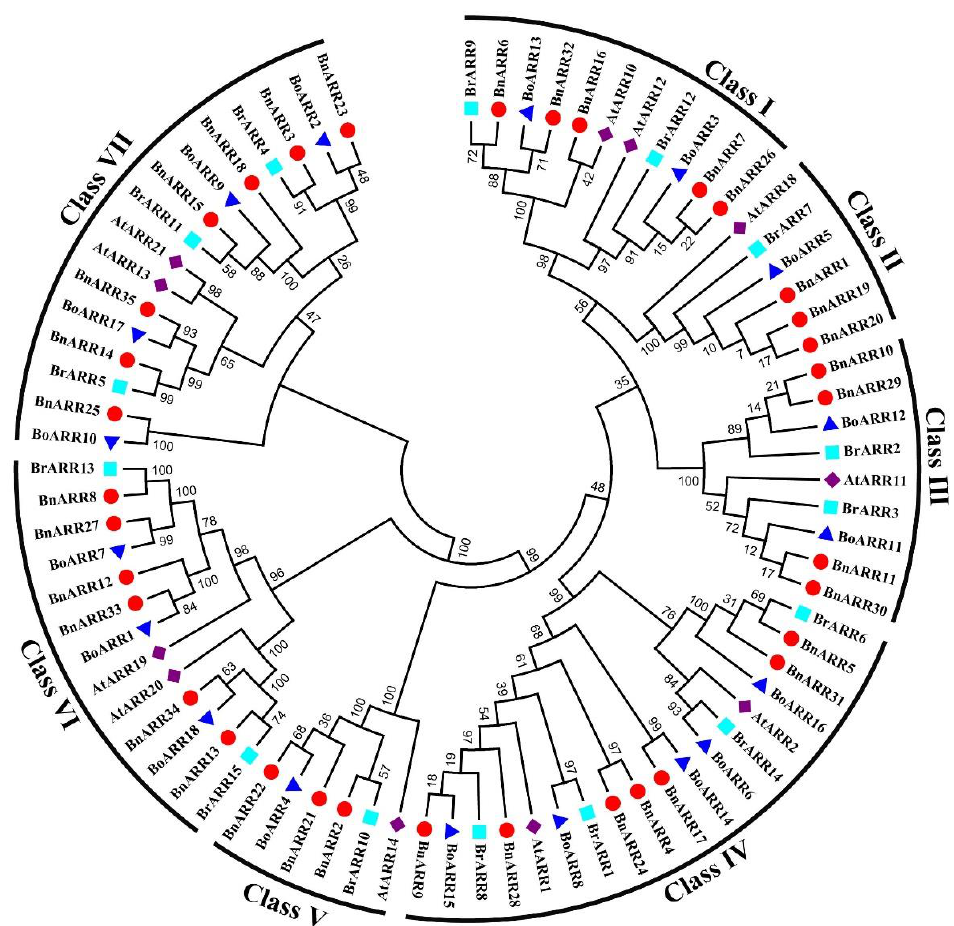
Figure 2. Phylogenetic tree of type-B ARRs in B. napus , B. rapa , B. oleracea , and A. thaliana . The numbers on branches represent the reliability percent of bootstrap values.